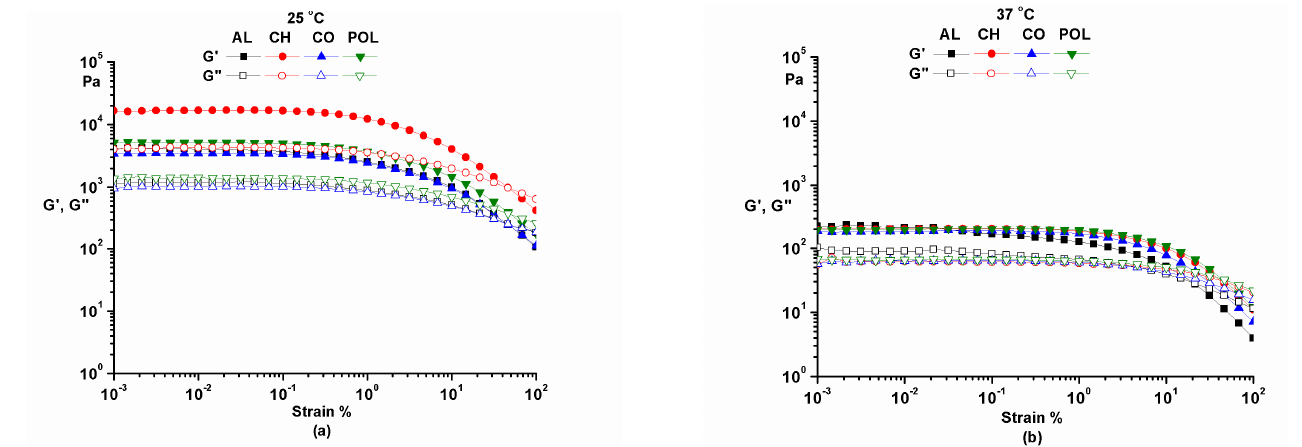
Figure 1. Amplitude sweep at 25 ◦ C ( a ) and 37 ◦ C ( b ). The frequency sweep (Figure 2) was performed at a constant amplitude (in the limit of the linear viscoelastic range γ = 0.01% at 25 ◦ C and γ = 0.05% at 37 ◦ C). The angular frequency varied in the domain 0.1 ÷ 100